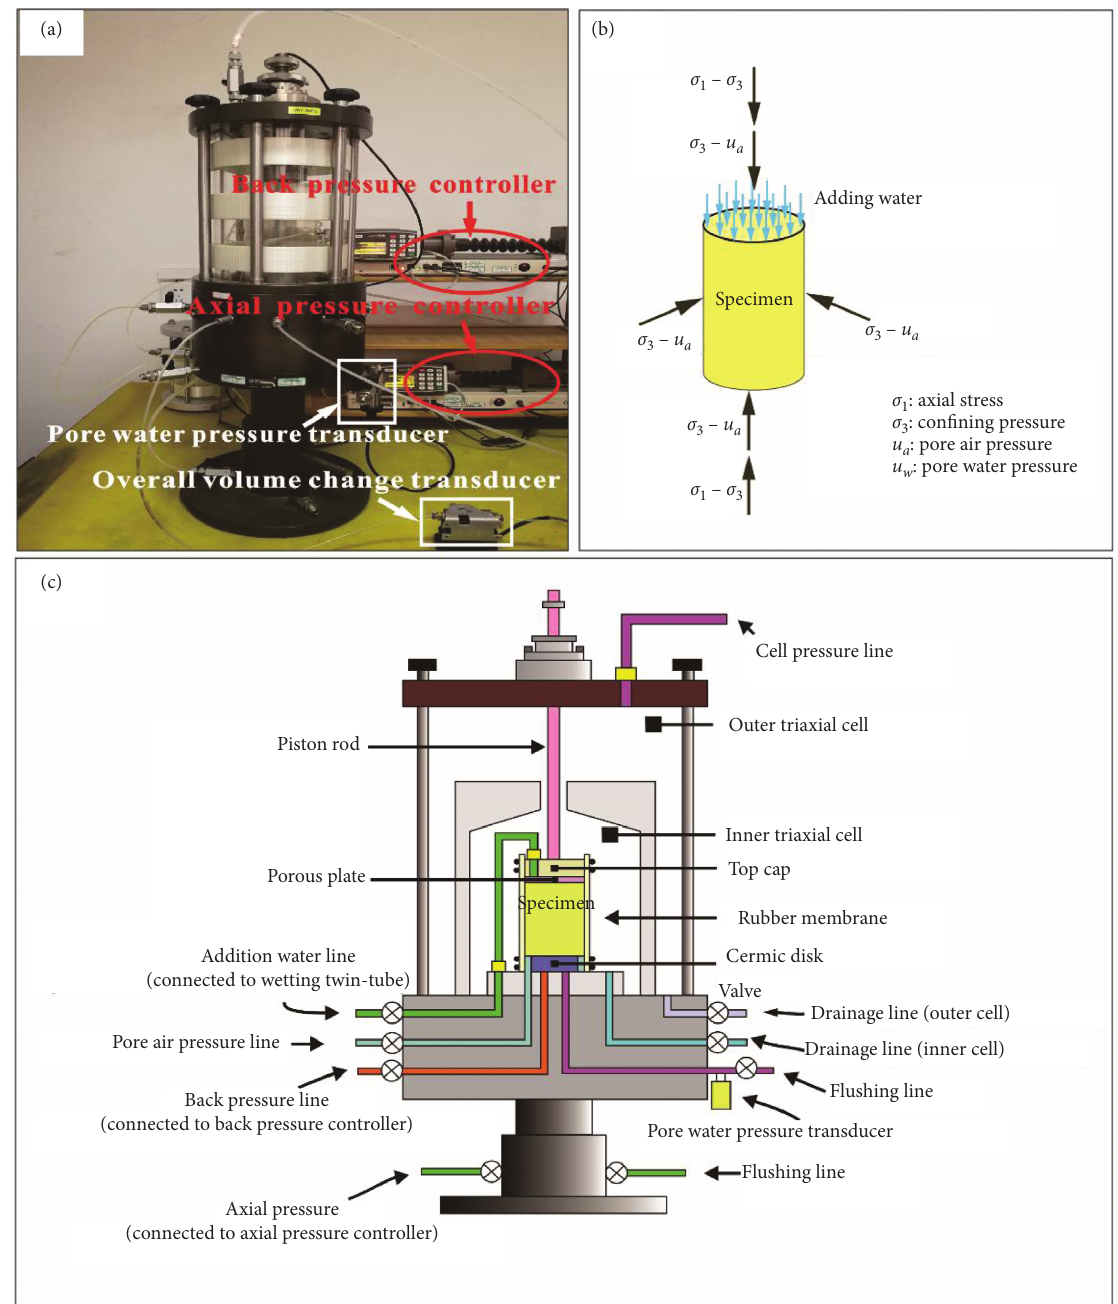
Figure 7: GDS triaxial test instrument (a) overview; (b) specimen in the triaxial cell; (c) schematic diagram of suction-monitored triaxial